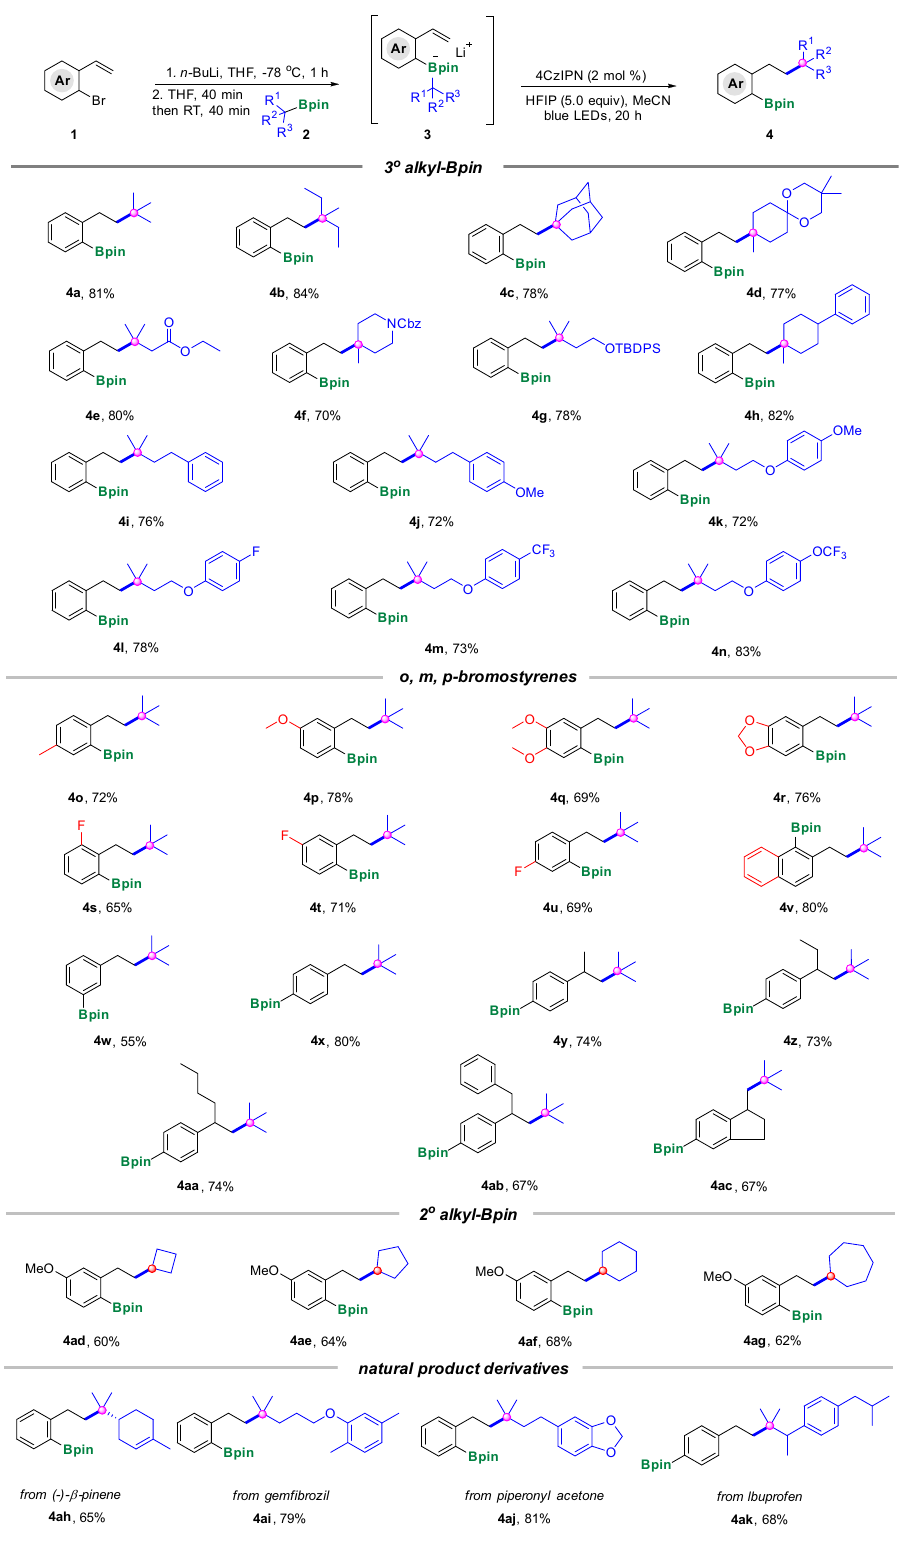
Fig. 2 Scope of alkyl boronic esters and bromostyrenes. [a] Reaction conditions: To a solution of bromostyrene 1 (0.26 mmol, 1.3 equiv) in THF (0.6 mL) was added n -BuLi (0.26 mmol, 1.3 equiv) − 78 °C under argon, the resulting mixture was stirred at − 78 °C for 1 h, then 2 (0.2 mmol, 1.0 equiv) in THF (0.2 ml) was added and stirred at − 78 °C for 40 min and warm to room temperature for 40 min, then followed by HFIP (1.0 mmol, 5.0 equiv) and 4CzIPN (2 mol%) in MeCN (2 mL, 0.1 M). The resulting mixture was irradiated by blue LEDs for 20 h. Cbz benzyloxycarbonyl, TBDPS tert